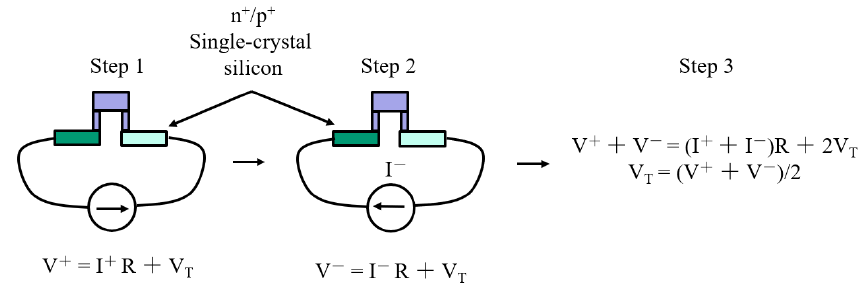
Figure 2. Schematic diagram showing the bi-directional electrical biasing measurement